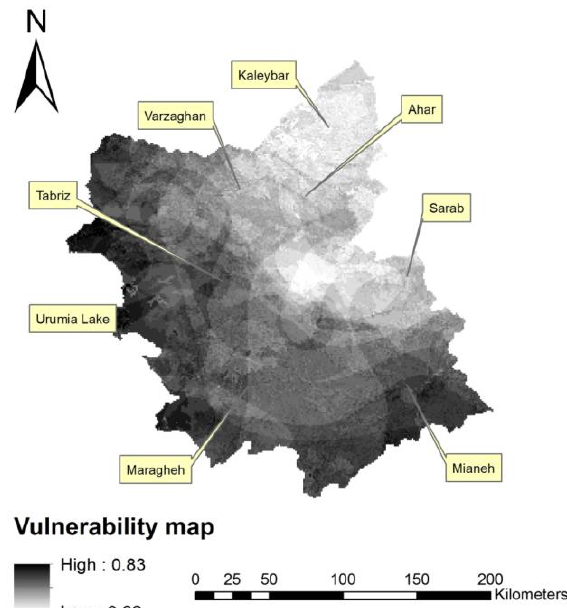
Figure 2- Final vulnerability map including some strategic locations